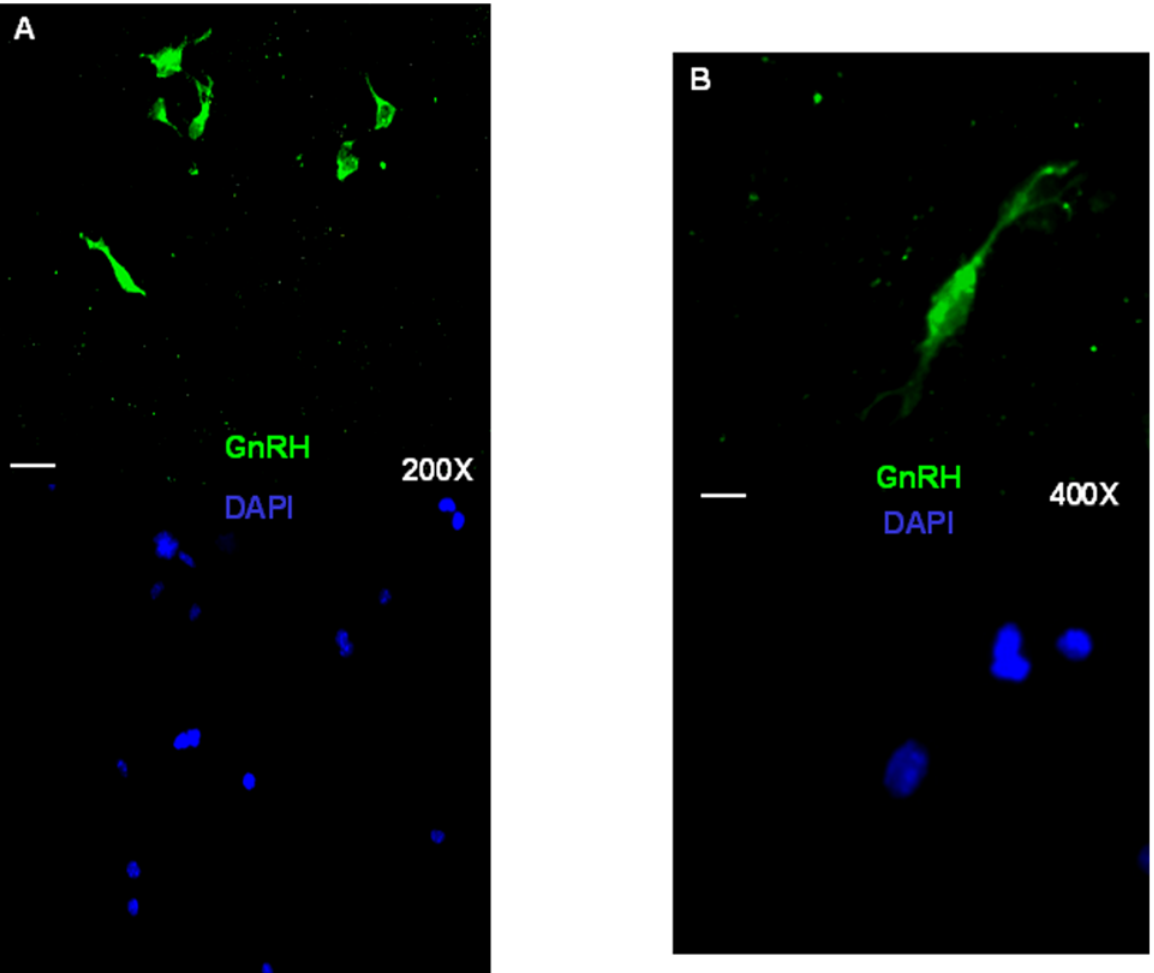
Figure 6. GnRH-immunoreactive cells as detected by a specific anti-GnRH antibody in differentiating fetal hypothalamic NS cultures. Representative fluorescence micrographs showing some GnRH-labeled immunofluorescent cells (green fluorescence) as detected in differentiating cultures kept for 5 days in DMEM/F12, FGF-2 (20ng/mL) followed by 5 days in DMEM/F12, B27 (0.5%). Duplicate pictures show the nuclei stained in blue by the dye DAPI. Scale bars: 20 m m (A panel) and 10 m m (B panel).